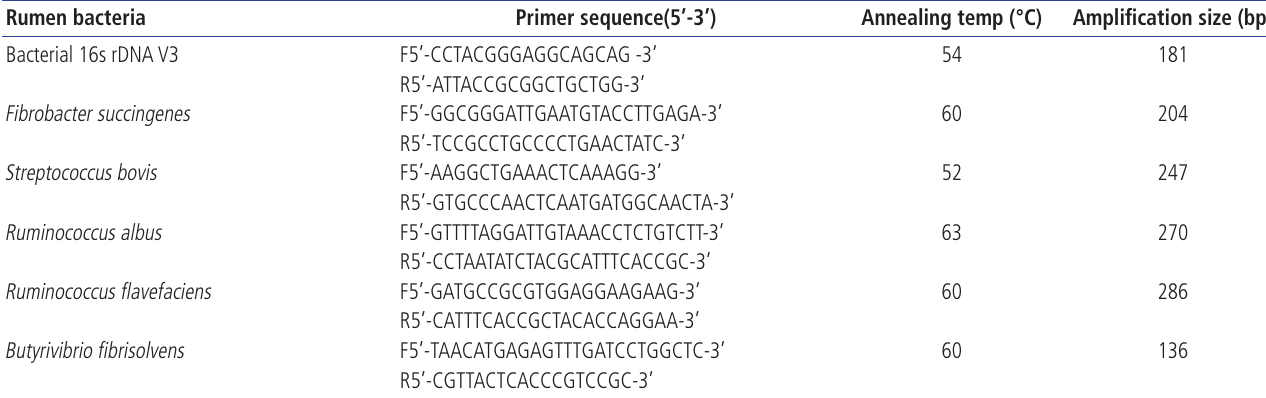
Table 2. Primer sequences for polymerase chain reaction of rumen bacteria Rumen bacteria